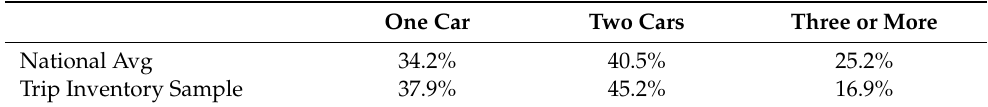
Table 3. This sample’s proportion of multiple-vehicle ownership, compared with the contemporane-